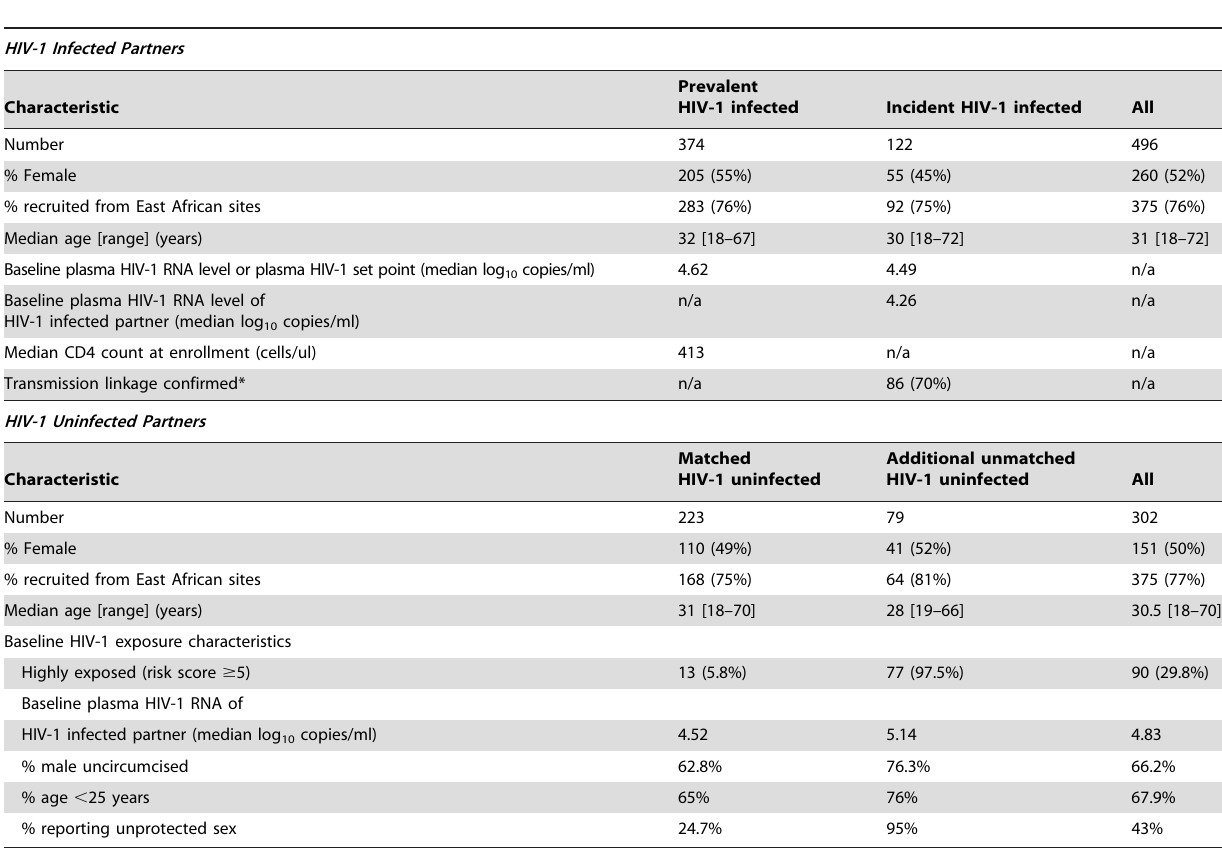
Table 3. Epidemiologic Characteristics of Individuals in HIV-1 Acquisition